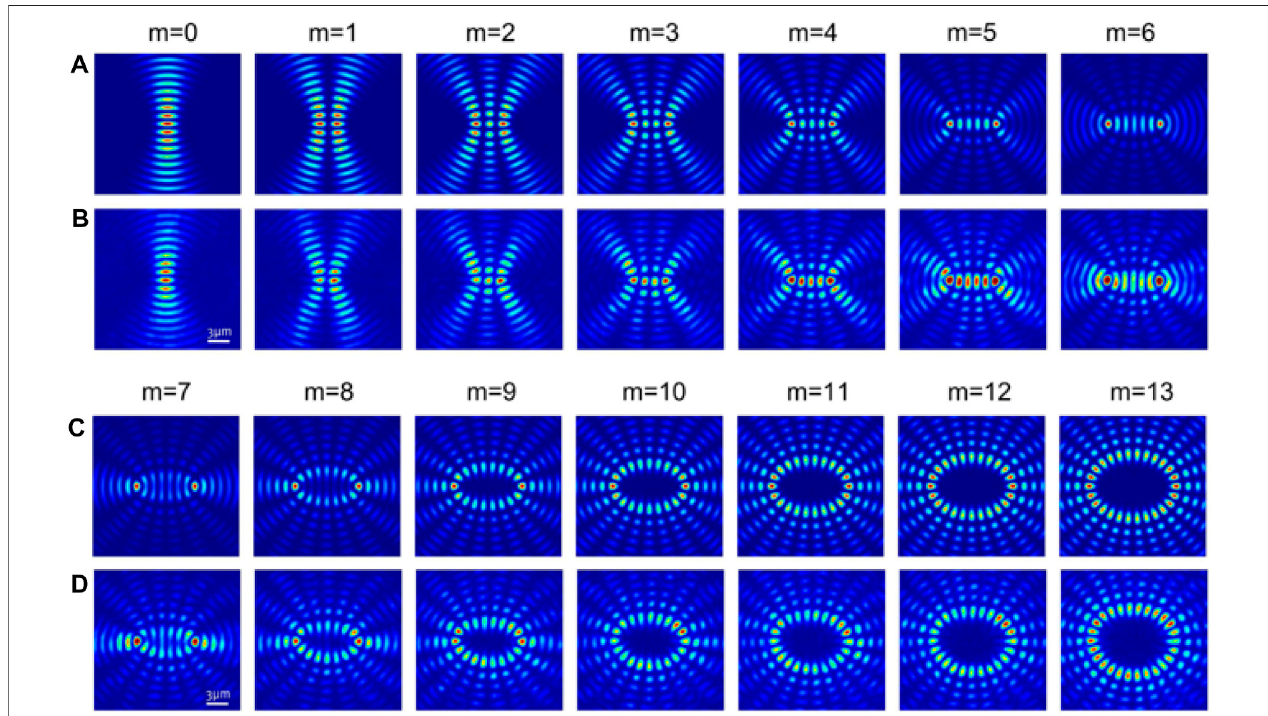
FIGURE 4 | Cross-sections of Mathieu beams. (A,C) Theoretical and (B,D) experimental pro fi les of the Mathieu beams with different order m . Reproduced from OSA [49].